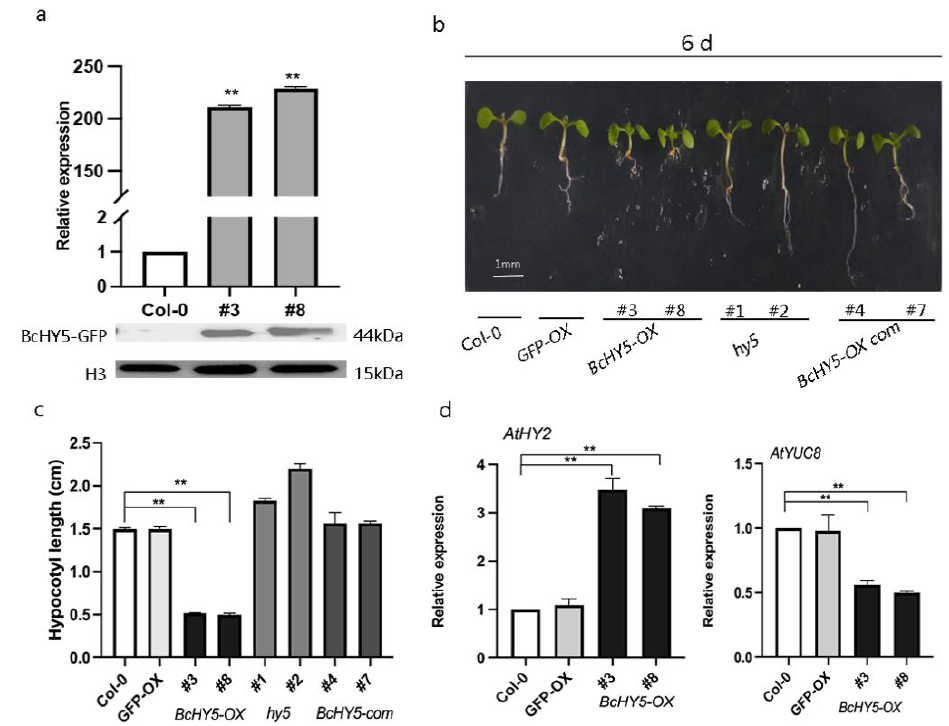
Figure 3. The BcHY5 -overexpression in Arabidopsis . ( a ) The expression level of BcHY5 in WT and transgenic lines. ( b ) and ( c ) Hypocotyl phenotypes and length of WT, hy5 , and transgenic lines BcHY5 of 6-day-old seedlings. ( d ) The analysis of genes’ relative expression level related to hypocotyl length of 6-day-old seedlings. AtHY2 The unit of hypocotyl length is millimeters. Error bars represent the standard deviation among independent replicates. Asterisks (** p < 0.01, Student’s t -test) indicate statistical significance.